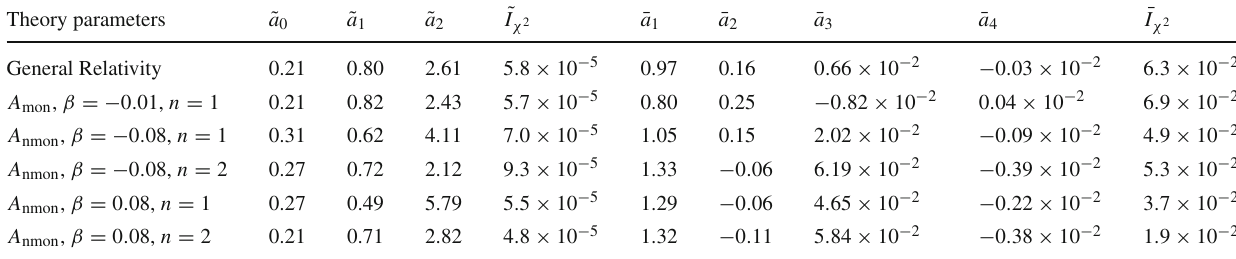
obtained from the fits of the data with polynomials of the form (28) and (29). We have chosen some representative combinations of param- eters for both coupling functions, where A mon denotes the